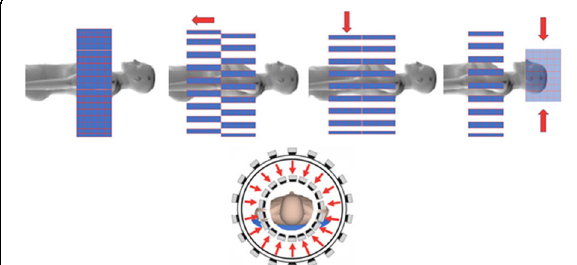
Fig. 1 (abstract A15). Illustration of the concept. The standard tight structure of 36 modules x4 rings with axial coverage of 25 cm gets separated into two sparse sections by an axial shift of about 25 cm. After angular rotation of 10 deg the two components form a uniform picket fence 50 cm long. As an example, after position adjustment in the axial coordinate one of the sectors gets compressed by factor ~2 to form high resolution and high sensitivity brain imager. Dynamic imaging of brain plus other organ(s) can be performed. Here is shown example of simultaneous dynamic heart-brain correlation imaging configuration. Other could be brain-spleen, brain-liver, etc